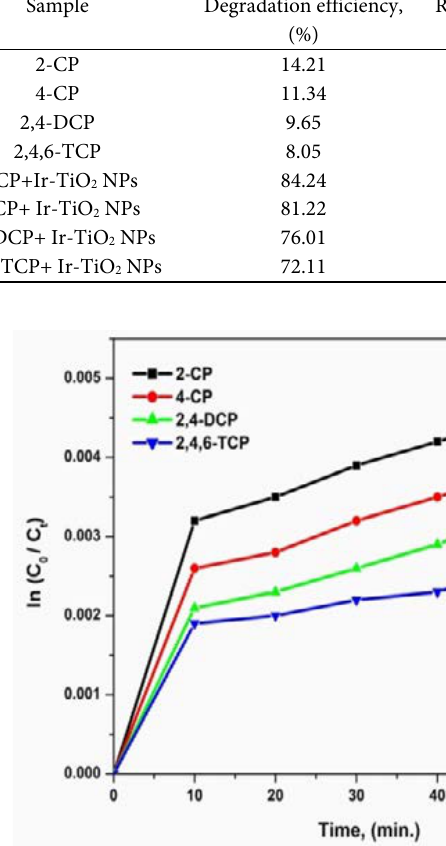
Fig. 11: The kinetic plots of the photocatalytic degradation of 2-CP, 4-CP, 2,4-DCP and 2,4,6-TCP in the absence of Ir-doped TiO